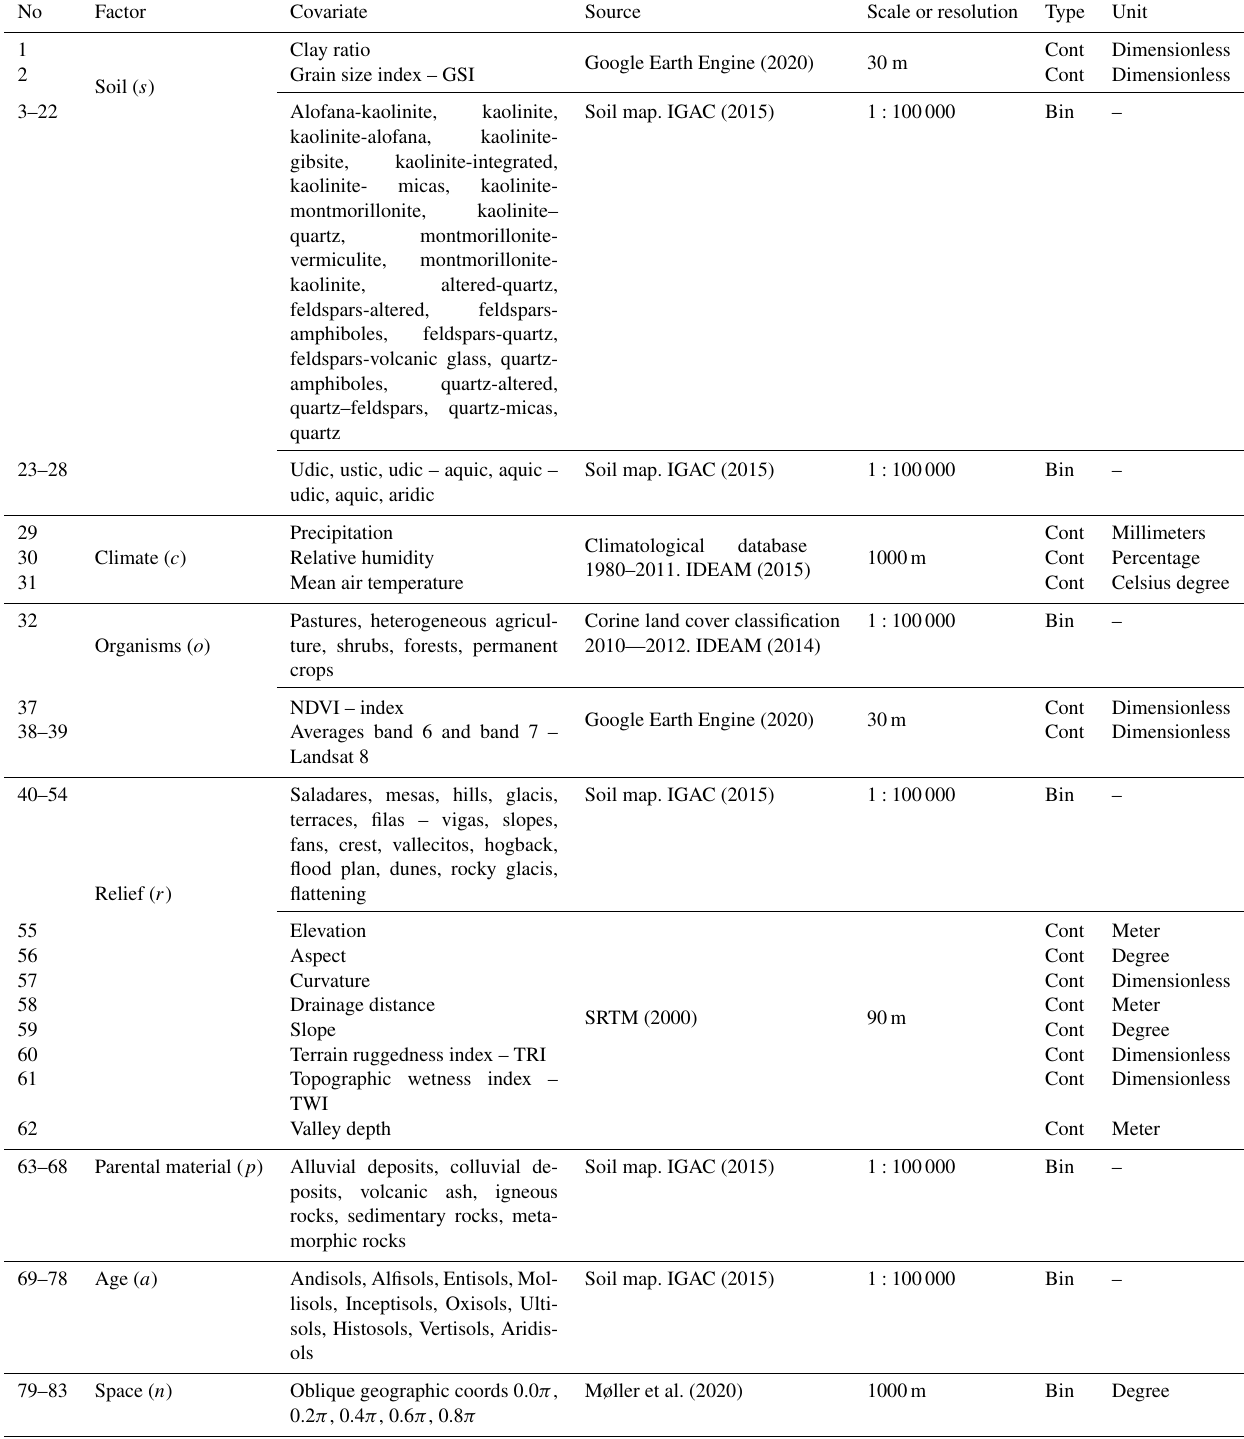
Table 1. Environmental covariates by soil forming factor. Cont: continuous; Bin: